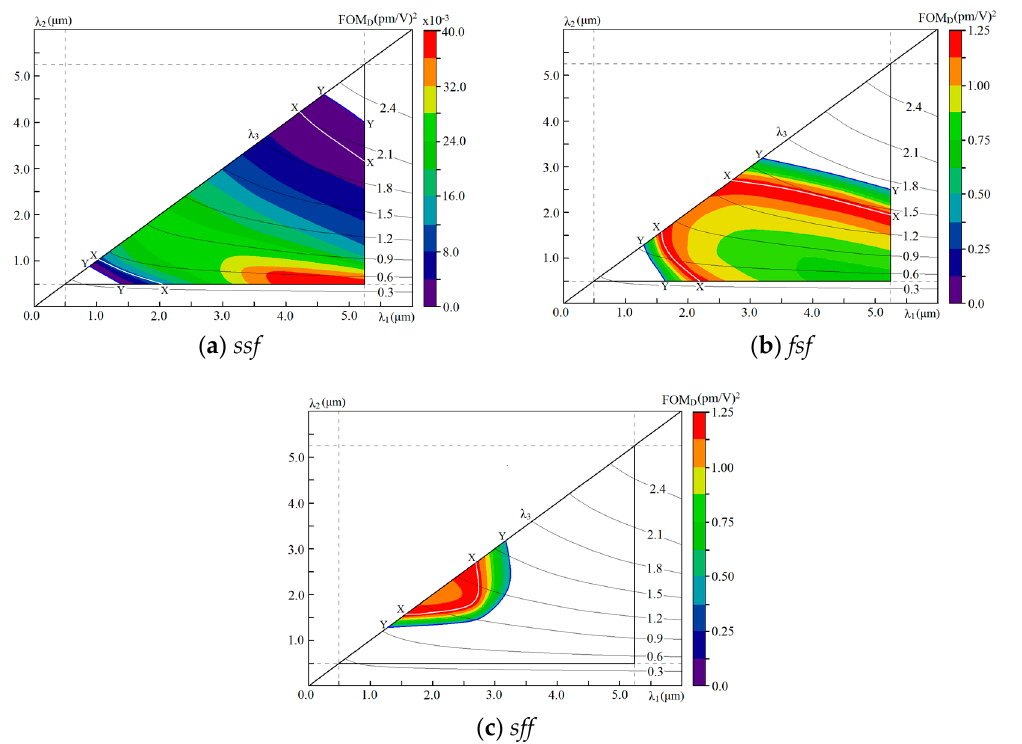
Figure 10. FOM D ( λ 1 , λ 2 ) distributions for CTA crystal for all types of interactions: ( a ) ssf , ( b ) fsf , ( c ) sff .